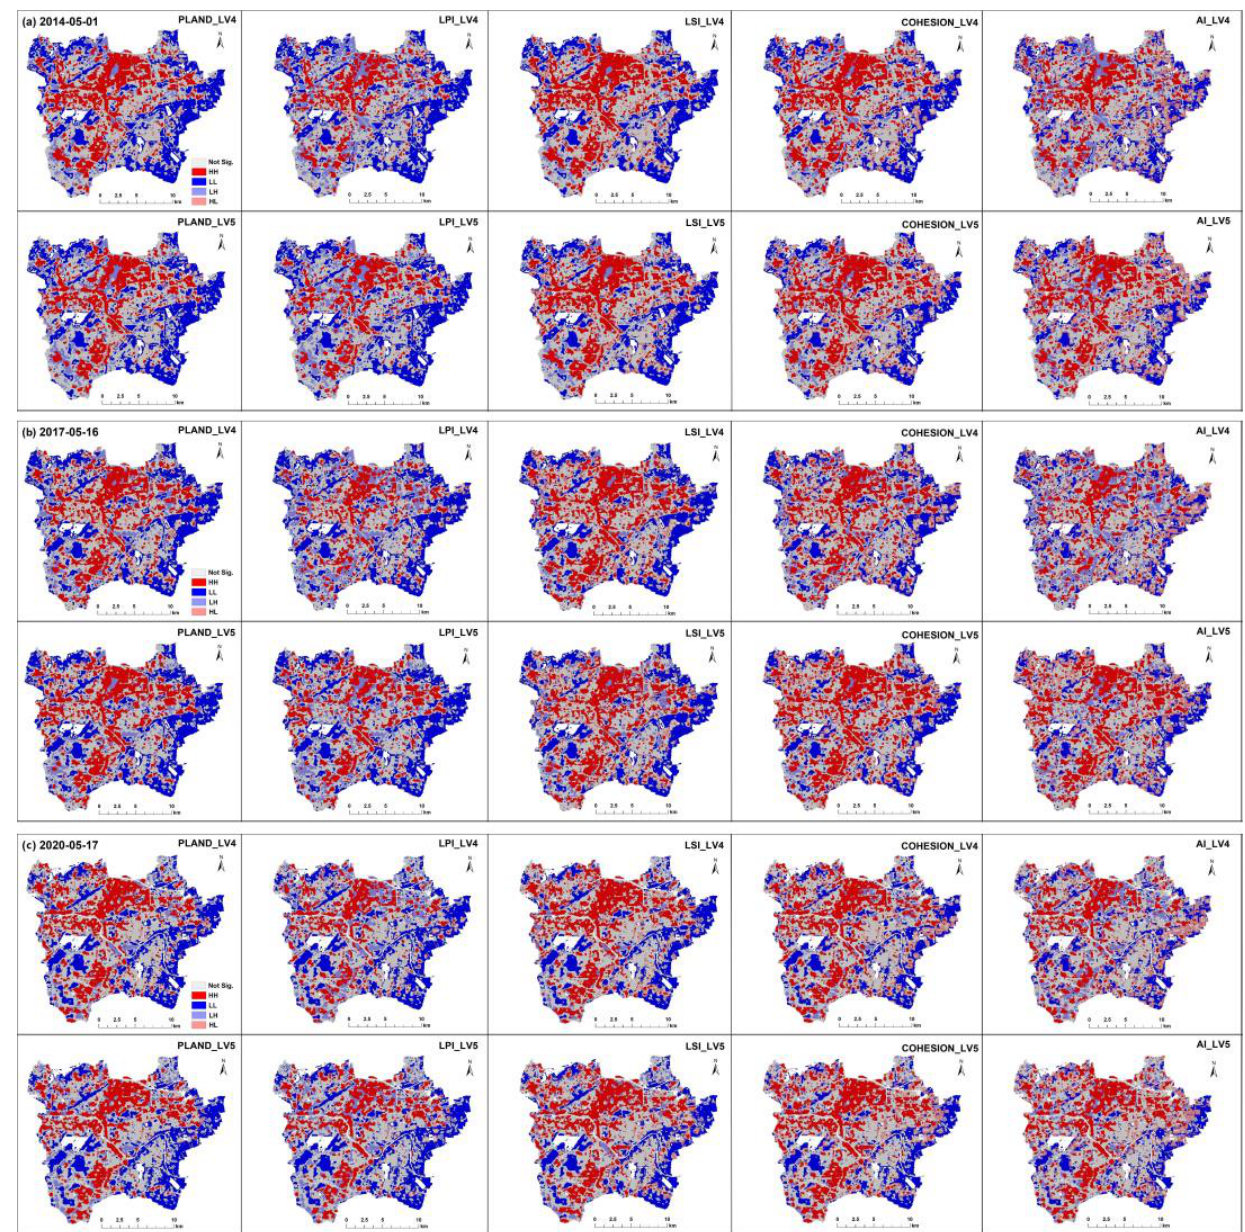
Figure 8. LISA maps between landscape metrics of IPSD LV4 or LV5 and LST (HH refers to the spatial aggregation of high landscape metrics and high LST; LL refers to the spatial aggregation of low landscape metrics and low LST; HL refers to the spatial aggregation of high landscape metrics and low LST; and LH refers to the spatial aggregation of low landscape metrics and high LST). ( a ) 2014-05-01; ( b ) 2017-05-16; ( c ) 2020-05-17.